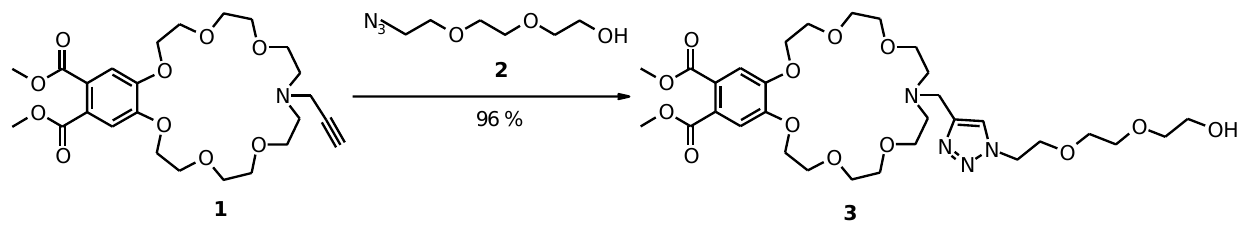
Scheme 1. Synthesis of a lariat ether ( 3 ) by copper(I) mediated dipolar